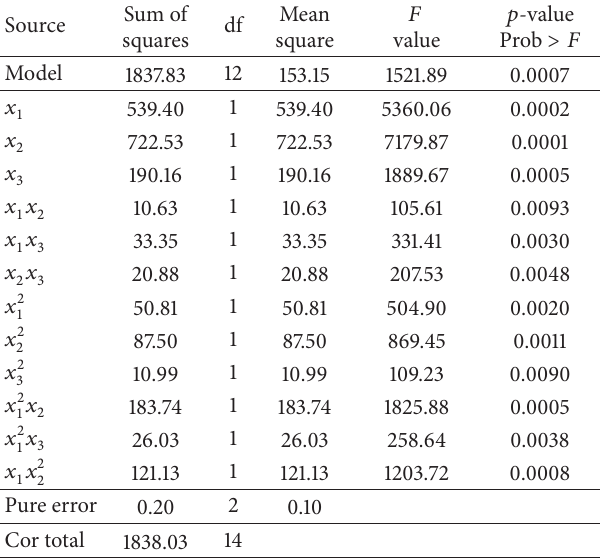
Table 3: Analysis of variance (ANOVA) for the reduced cubic